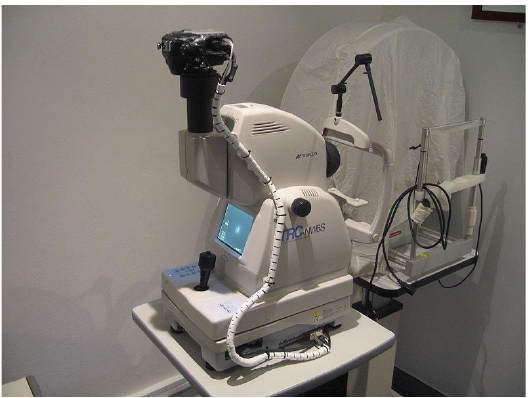
Figure 16. Examples of fundus cameras used in healthcare facilities [75].